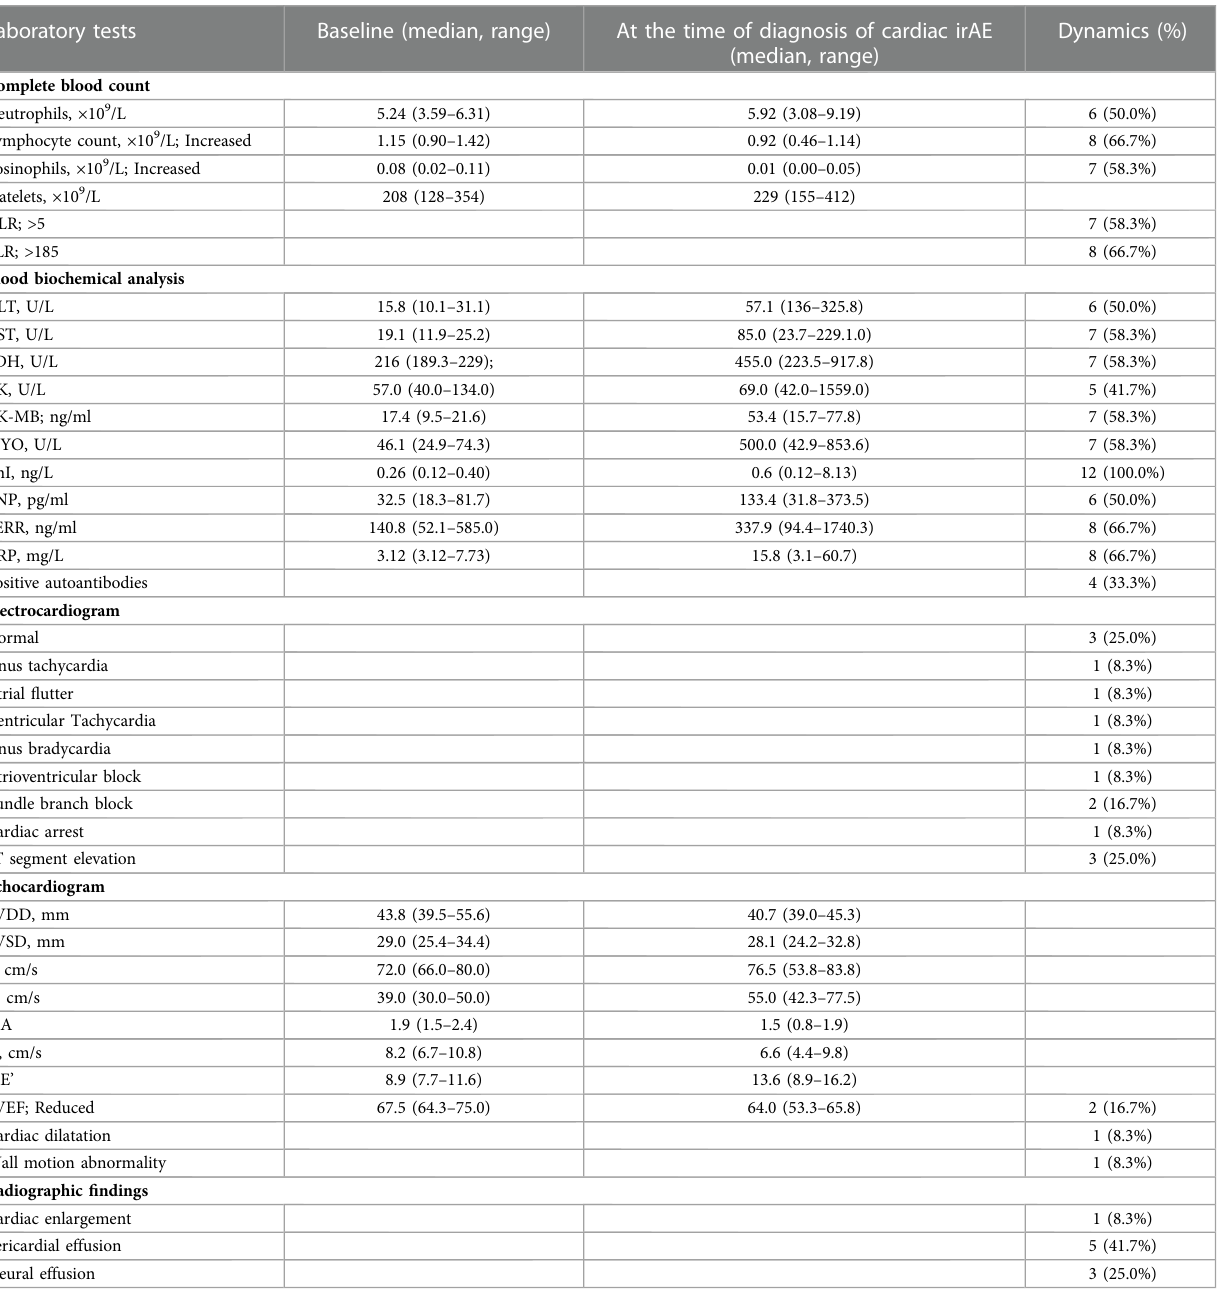
TABLE 3 Laboratory tests and other tests for patients with cardiac